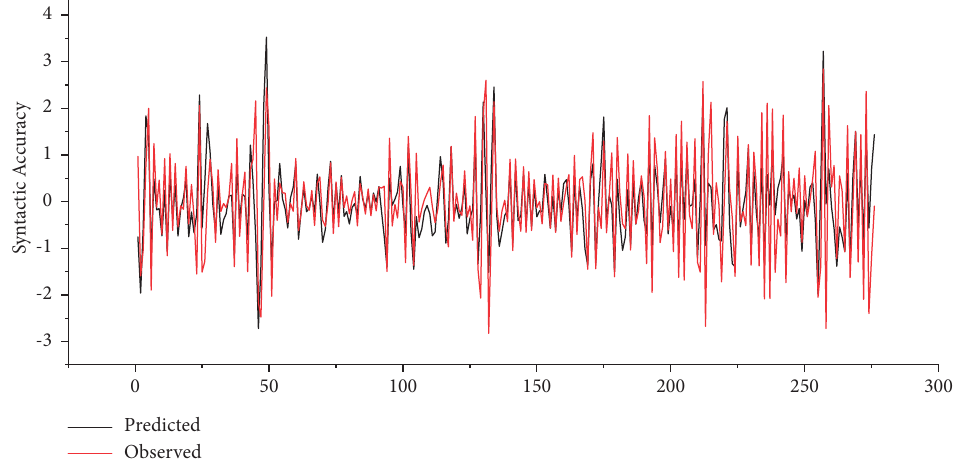
Figure 9: Comparison of the model’s prediction curve and actual curve for the sentence accuracy of the test in the seventh writing task.